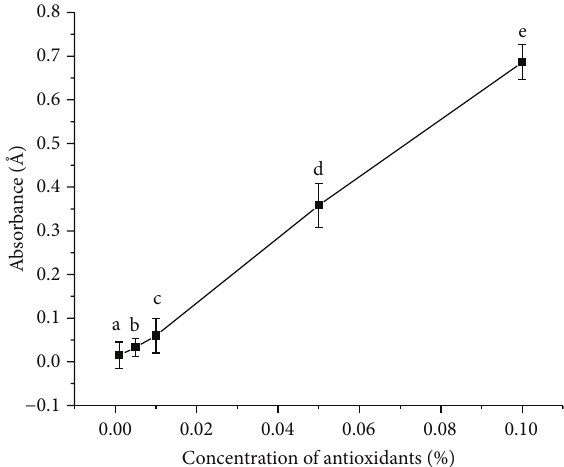
Figure4:Reducingactivityof 𝛼 -and 𝛽 -carotenecrystalsatdifferent concentrations. Values are Mean ± SEM of 3 observations. At the 0.05 level, the difference in superscripts (a, b, c, d, e) indicates significant difference in